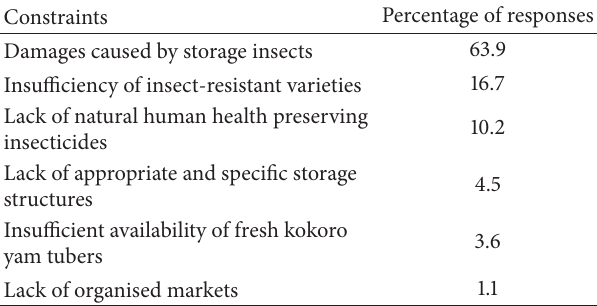
Figure 3: Yam chips with insect infestation in Benin. Table 2: Yam chips production constraints in Benin.